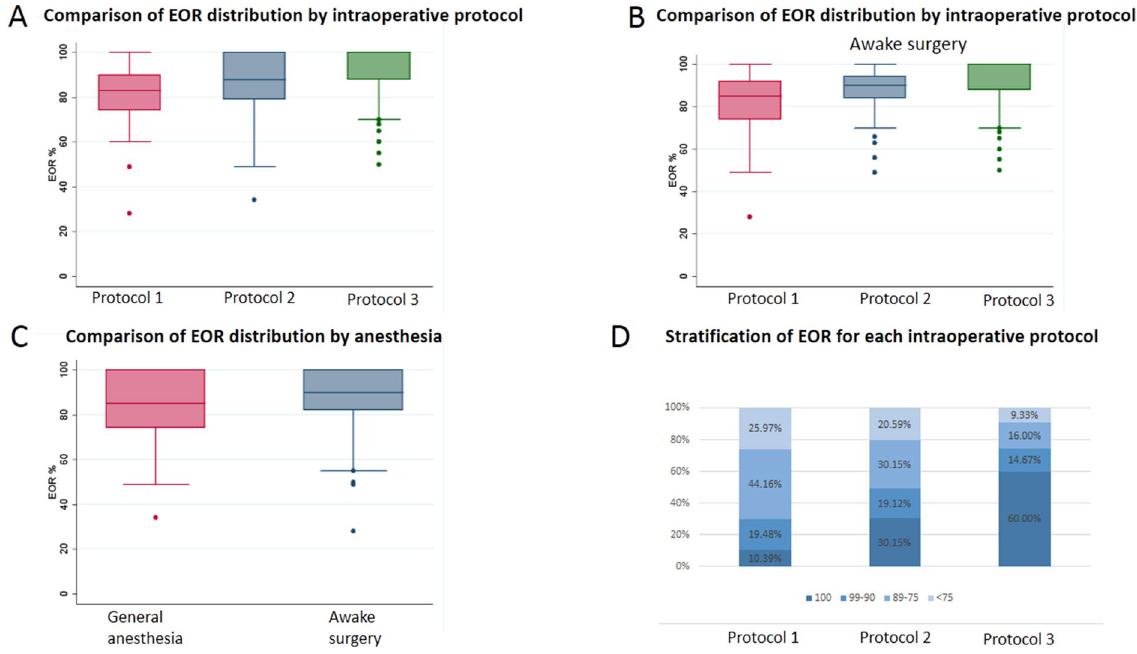
Figure 1. Difference achieved in tumor resection according to the intraoperative protocol used. ( A ) shows the median EOR achieved in patients operated with general anesthesia and awake craniotomy. In ( B ) the EOR data are stratified according to the intraoperative surgical protocol. Protocol 1 (Mapping) had a median EOR of 83%, while Protocol 2 (Mapping + DTI + fMRI) had a median EOR of 88% and Protocol 3 had a median EOR of 100%. ( C ) displays the median EOR achieved in the subgroup of patients who underwent awake craniotomy: Protocol 1 (Mapping) 85%, Protocol 2 (Mapping + DTI + fMRI) 90% and Protocol 3 100%. The circles represent the outlier values. ( D ) is a bar chart representing the distribution of EOR as a categorical variable in the three surgical protocols. EOR Extent Of Resection.